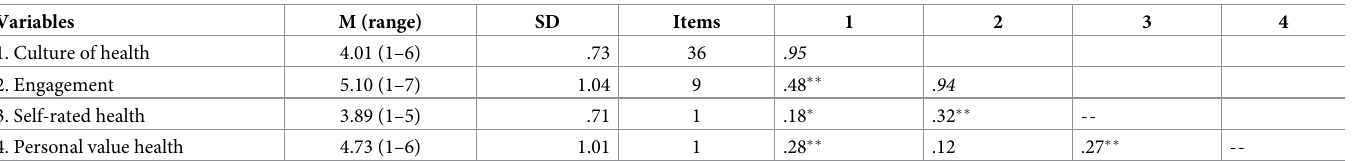
Table 2. Means, standard deviations, correlations and Cronbach’s alphas of study variables.